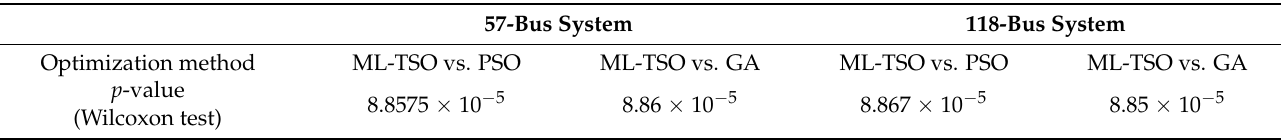
Table 10. p -Values of Wilcoxon’s rank-sum